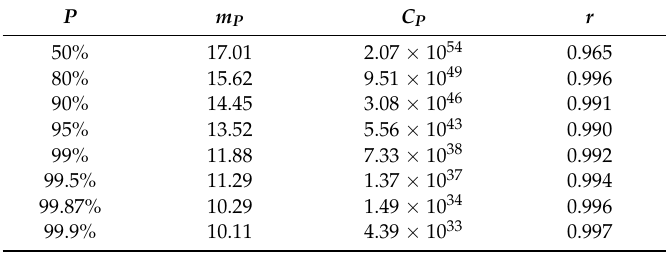
Table 3. Parameters of the P-S-N curve based on a BLG.